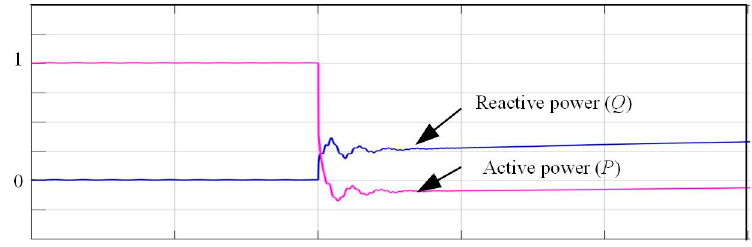
Figure 10. Waveforms of active and reactive power with 70% voltage drop ( t : 0.5 s/div). Energies 2019 , 12 , 319 11 of 13